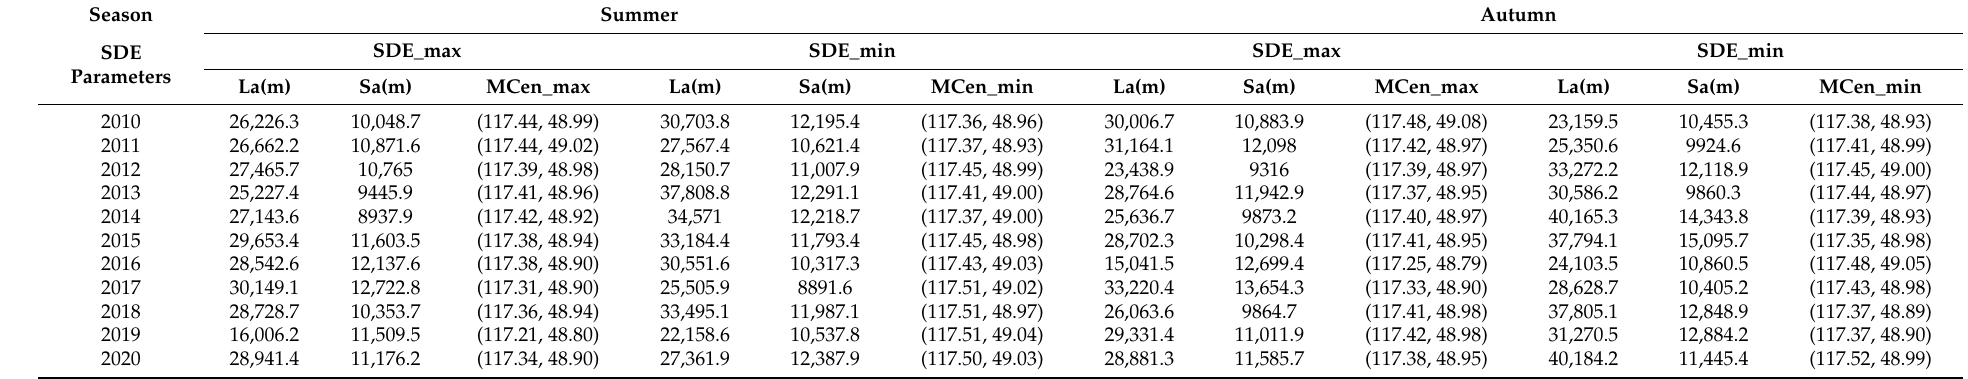
Table A2. SDE parameters of